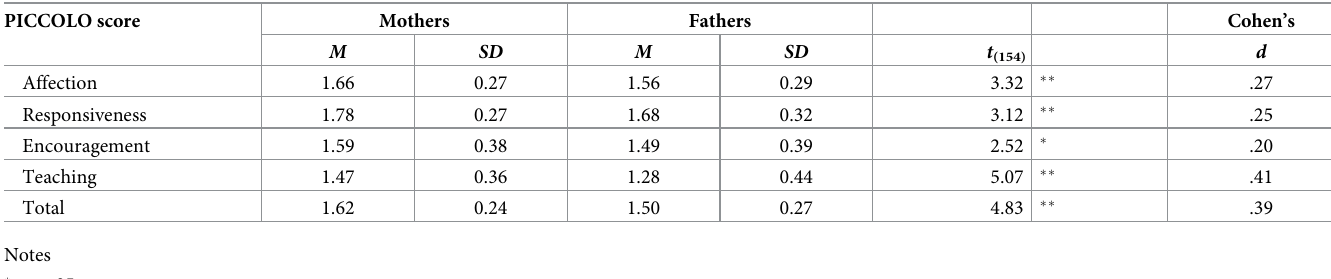
Table 2. Differences between mothers and fathers in PICCOLO mean scores (N = 155).